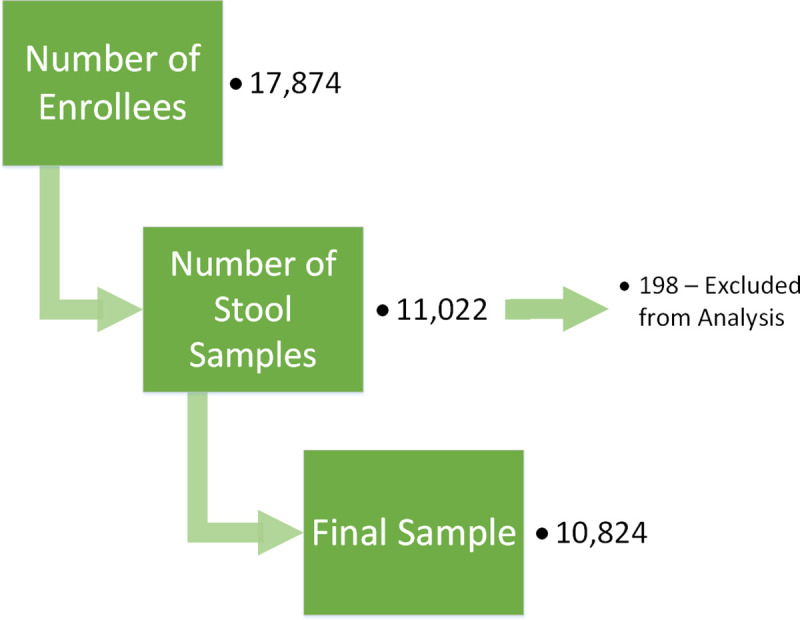
Flow chart of sample selection and final number of observations.